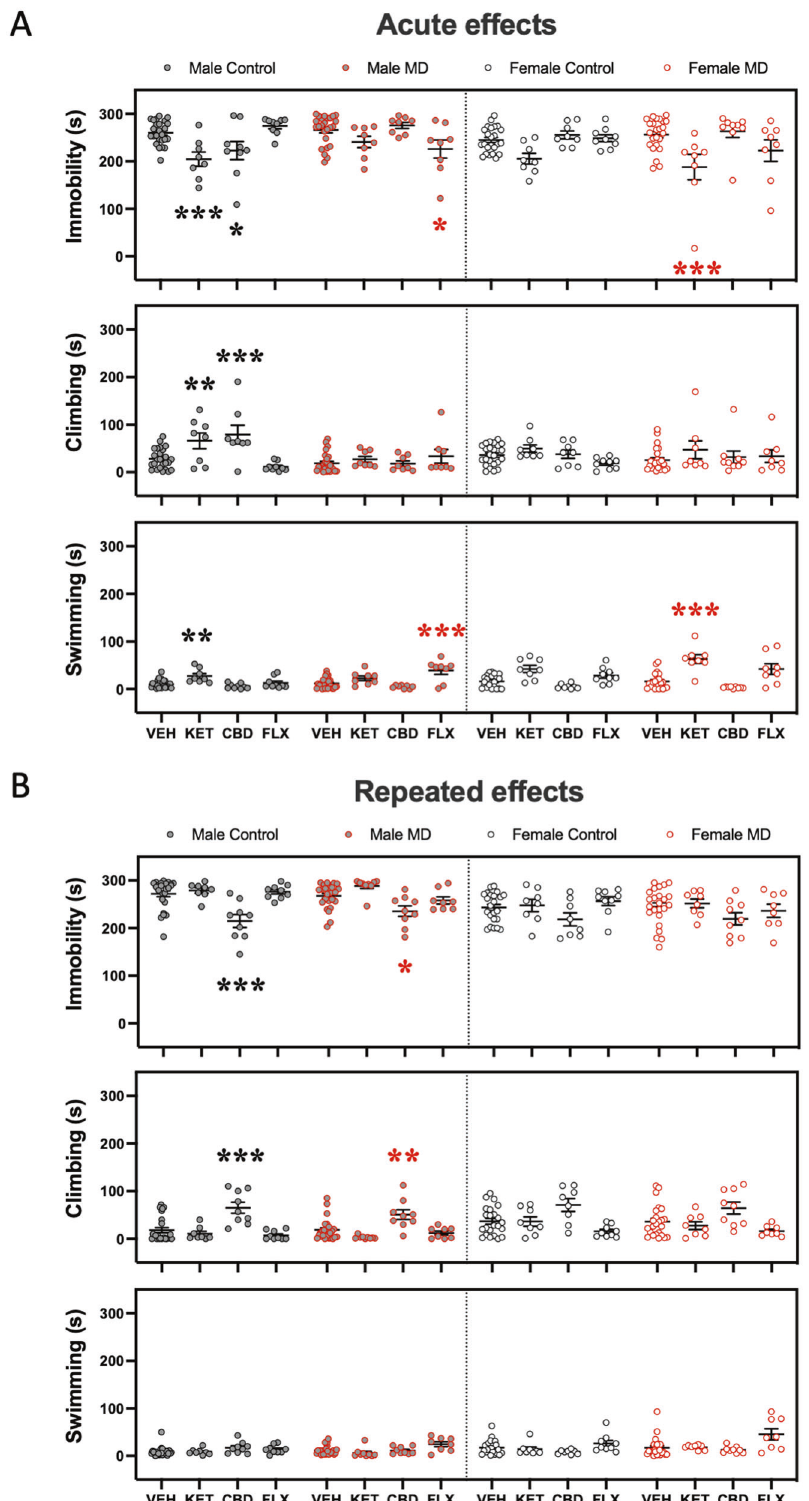
Fig. 2 Antidepressant-like effects as measured in the forced swim test (FST) during adolescence. A Acute (30 min post-treatment) and B repeated (1-day post-treatment) effects exerted by adolescent ketamine, cannabidiol, or fl uoxetine exposure in male and female rats (Control or MD) in the FST. Data represent mean ± SEM of the time spent (s) immobile, climbing, or swimming. Individual values are shown for each rat (symbols). Three-way ANOVAs (independent variables: sex, early-life, and treatment) and two-way ANOVAs (independent variables: early-life and treatment) are shown in Supplementary Tables 1 and 2 respectively. *** p < 0.001, ** p < 0.01, and * p < 0.05 vs. the appropriate control group (Control or MD) and